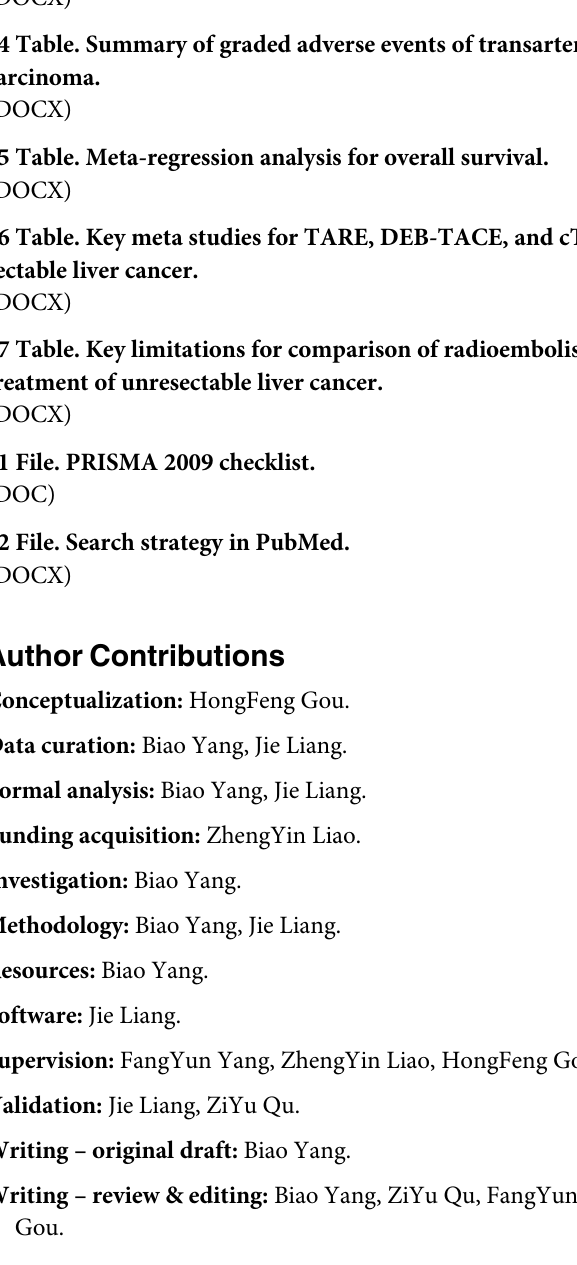
S2 Table. The endpoints of transarterial therapies for hepatocellular carcinoma. S3 Table. The comparison of main adverse events in the transarterial therapies for hepato- cellular carcinoma. S4 Table. Summary of graded adverse events of transarterial therapies for hepatocellular carcinoma. S5 Table. Meta-regression analysis for overall survival. S6 Table. Key meta studies for TARE, DEB-TACE, and cTACE in the treatment of unre- sectable liver cancer. S7 Table. Key limitations for comparison of radioembolisation and DEB-TACE in the treatment of unresectable liver